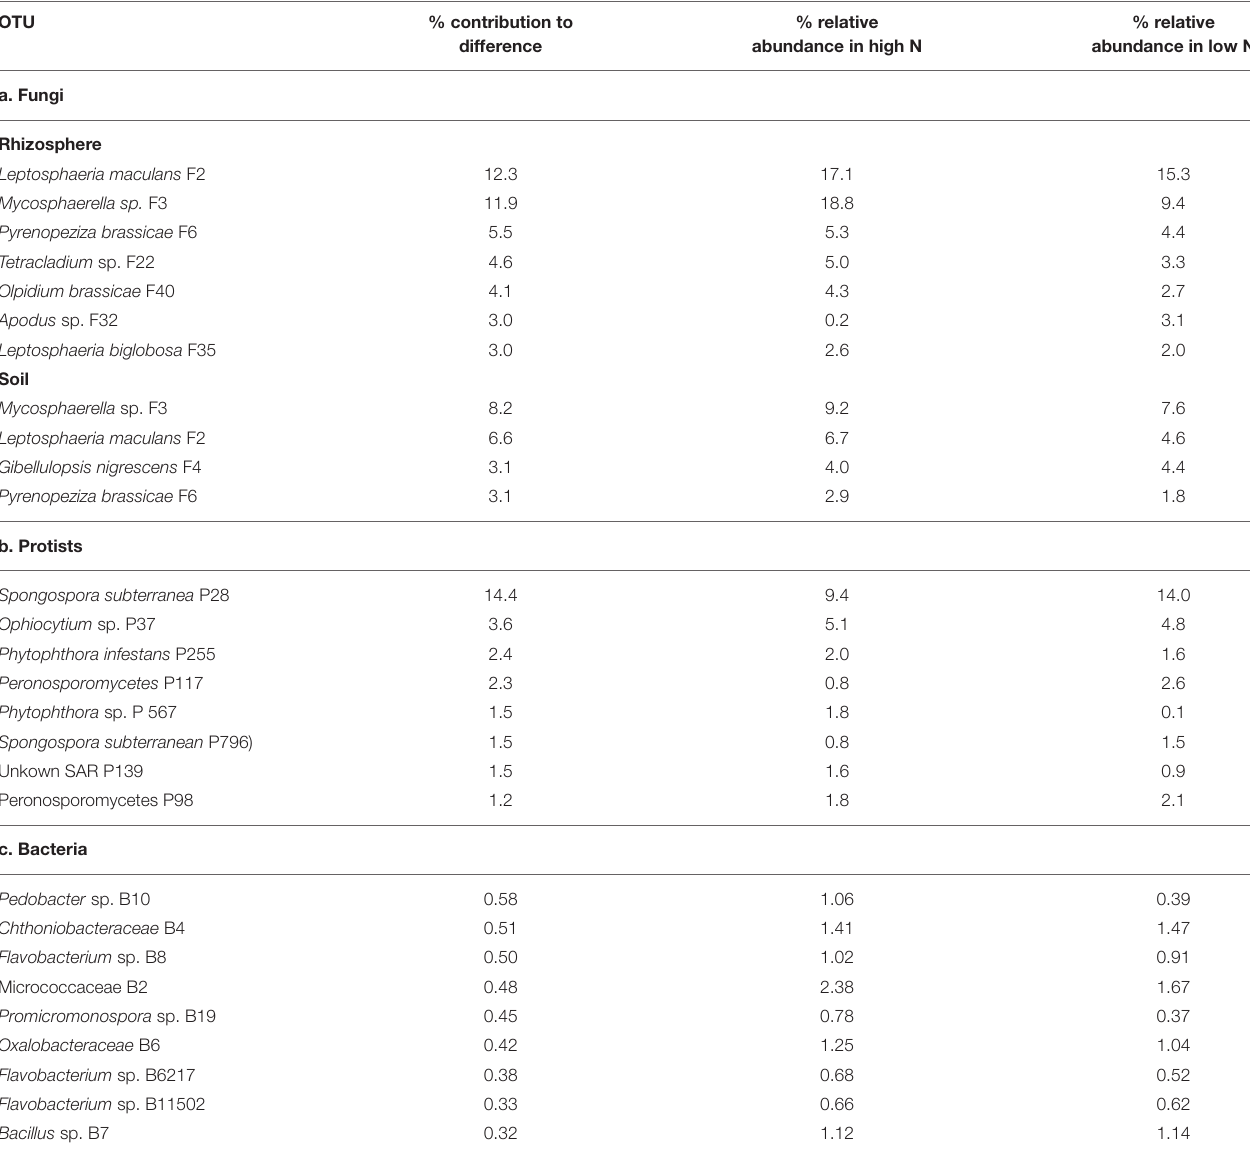
TABLE 3 | Analysis of similarity percentage (SIMPER) of differences in oilseed rape rhizosphere and soil fungal, protest, and bacterial OTU between high and low nitrogen treatments (with all 10 oilseed rape genotypes combined). OTU % contribution to